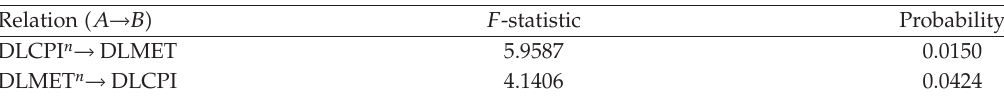
Table 3: Test for nonlinear causality (cid:5) asymmetric case for negative returns (cid:6) . If P > . 05, then at 5% we accept the null hypothesis that A does not cause B . The parameters for the M-G model were τ 1 (cid:8) 3, τ 2 (cid:8) 1, and (cid:8) c (cid:8) c 1 2